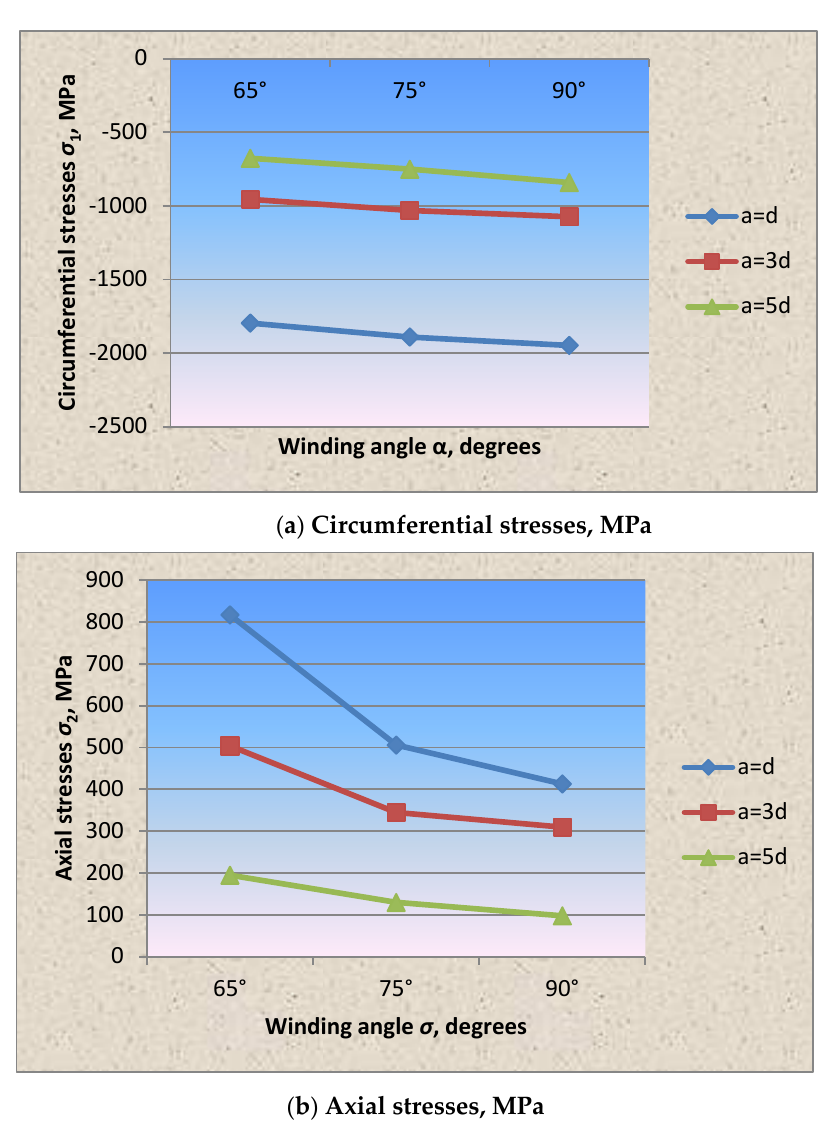
Figure 4. Dependence of the circumferential ( a ) and axial ( b ) stresses in the shell wall fragment with the winding wire diameter of 1.0 mm.